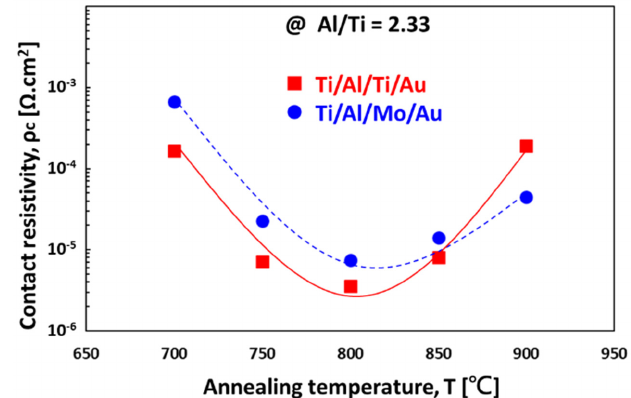
Figure 10. Ti/Al-based ohmic contacts on AlGaN/GaN HEMT as a function of annealing tempera- ture [66] . (Data from [66]).